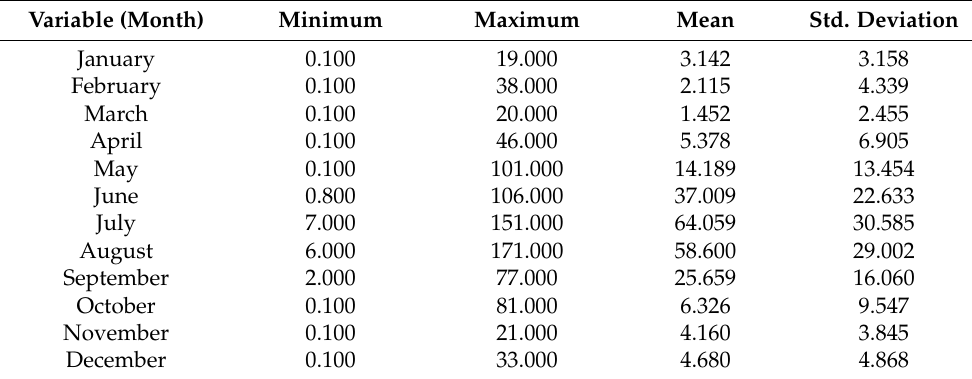
Table 3. Basic statistical characteristics of the Novoselenginsk rainfall